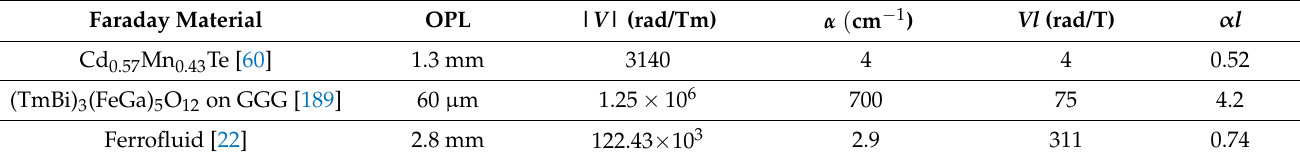
Table 2. Comparison of three Faraday structures for sensing